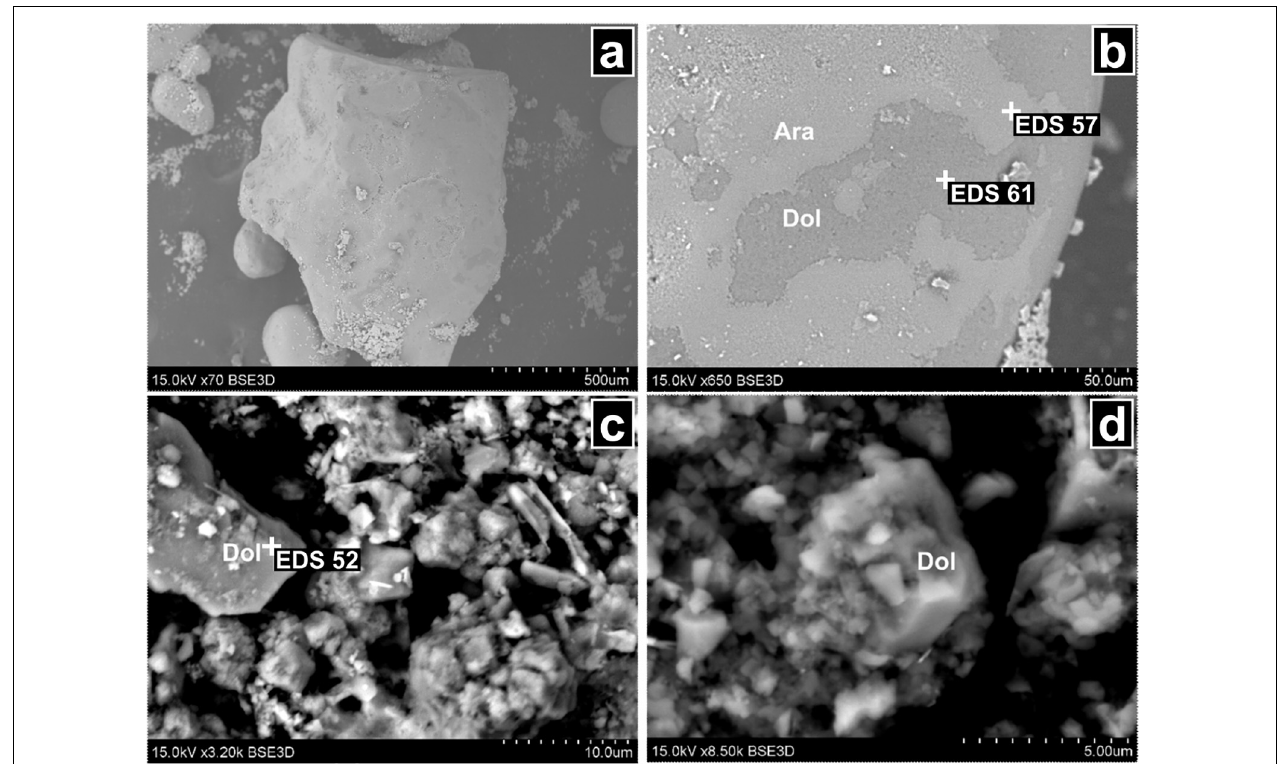
FIGURE 4 | Scanning electron microscopy (SEM) images of sediments from North Arm (NA) and South Arm (SA) cores. (a) Aragonite ooite from 1 cm depth in the NA core. (b) Increased zoom portion of a showing disordered dolomitic region in the aragonite ooite. (c,d) Euhedral protodolomite crystals from SA core, 0 and 24 cm in depth, respectively. Plus signs and labels indicate locations of energy dispersive X-ray spectroscopy (EDS) analyses, the results of which are presented in Supplementary Figures S2, S3 . Abbreviations: Dol, dolomite; Ara,